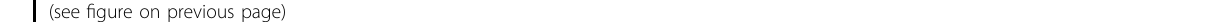
Fig. 2 T1DM mice exhibited greater downregulated expression level of WNT/ β -catenin signaling in trabecular bone than in cortical bone through inhibition of IGF-1R/Akt/GSK3 β pathway. a mRNA expression levels of IGF-1R, β -catenin, and canonical WNT target genes in trabecular and cortical bone. LEF1 lymphoid enhancer factor-1, TCF T cell factor, Axin2 axis inhibition protein 2, IGF-1R insulin-like growth factor-1 receptor. n = 8. b Western blots of IGF-1R, β -catenin, phosphorylated Akt, and GSK3 β in MC3T3-E1 cells exposed to normal glucose (control) or high glucose (HG). The protein levels were quanti fi ed by densitometry and represented graphically. n = 8. c Dickkopf-1 protein expression was detected by immunohistochemistry in longitudinal sections of femoral trabecular and cortical bone. The quantitative results are shown on the right. n = 9. Scale bars, 40 μ m. DKK-1 Dickkopf-1. Data are expressed as the mean ± SD. * P < 0.05, ** P < 0.01 versus Control group by an unpaired t